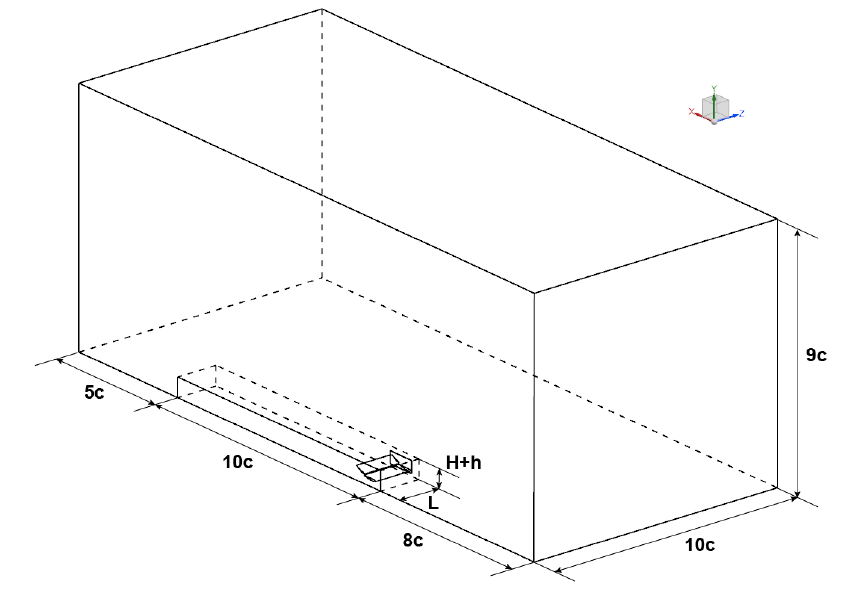
Figure 4. Domain used for numerical